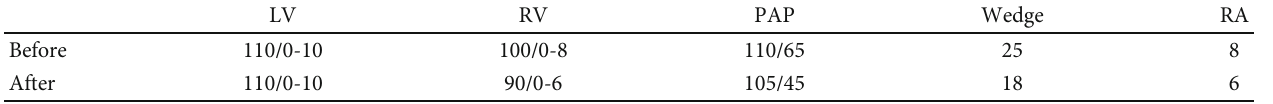
Table 1: Hemodynamic parameters (mmHg) before and after AFR device implantation.